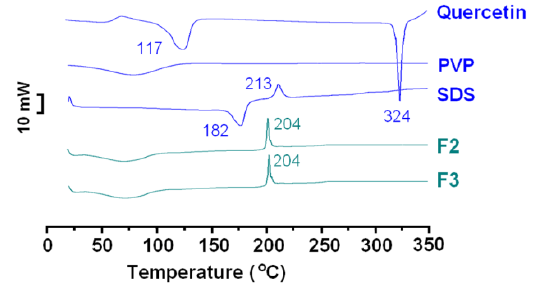
Figure 5. Physical status characterization: differential scanning calorimetry (DSC) thermograms of the raw materials (quercetin, PVP and SDS) and the core-sheath nanofibres, F2 and F3, prepared by coaxial